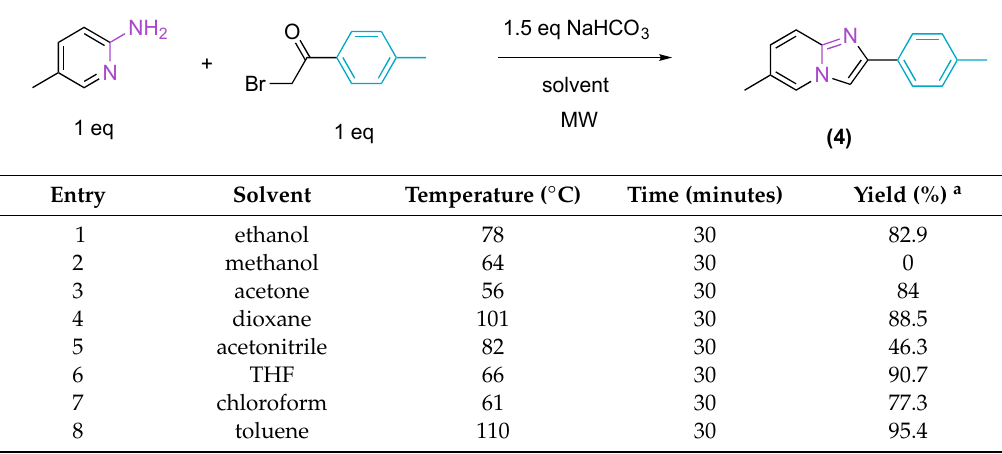
Table 1. Pilot study evaluating the effect of various organic solvents on microwave-supported condensation between 5-methylpyridin-2-amine and 2-bromo-1-(p-tolyl)ethan-1-one.